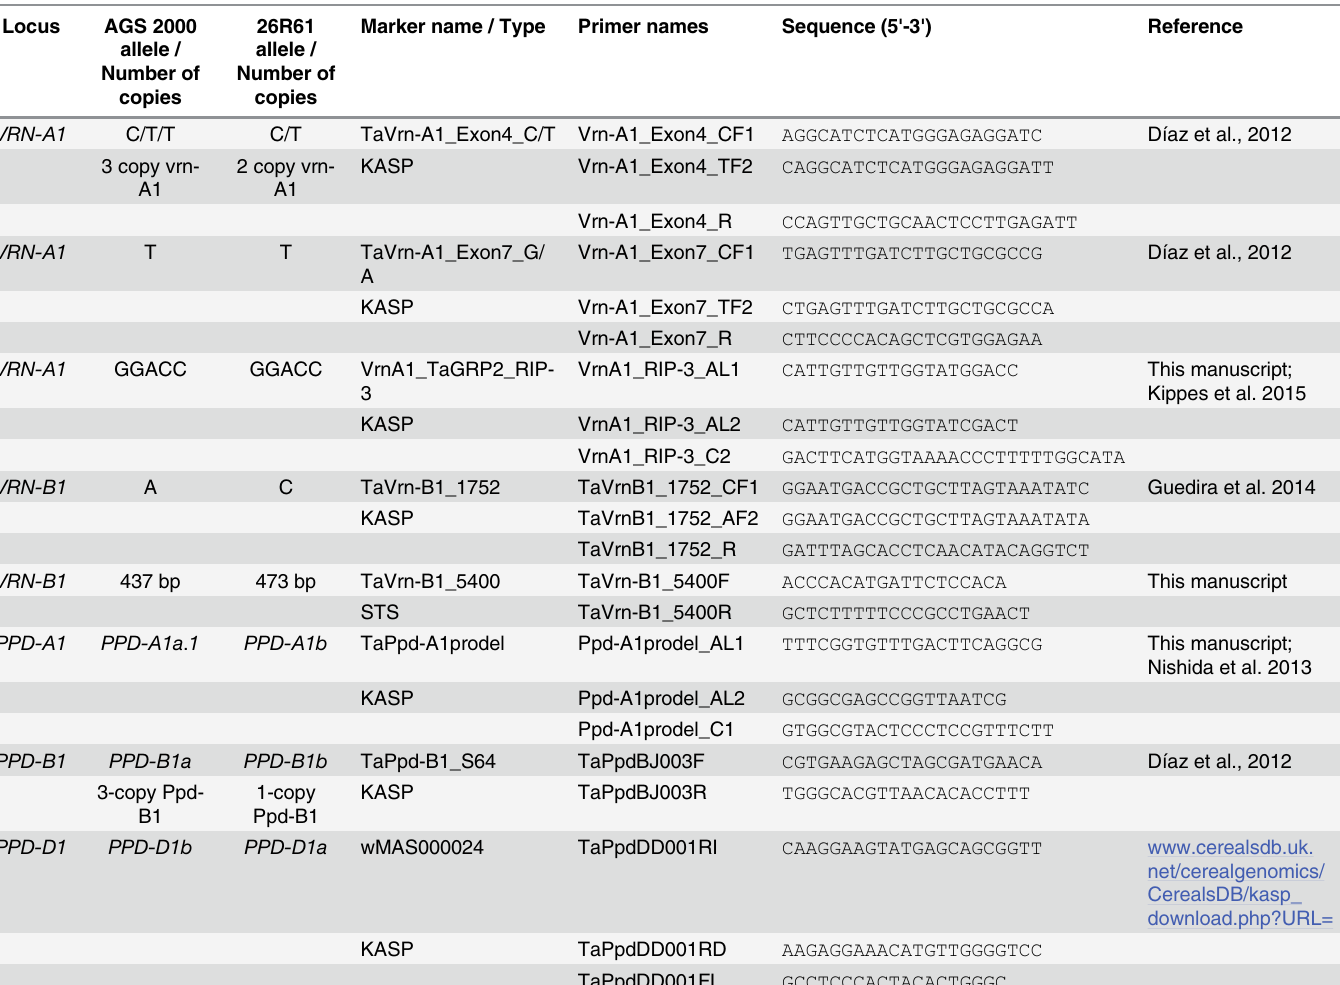
Table 1. Primers for major VRN1 and PPD1